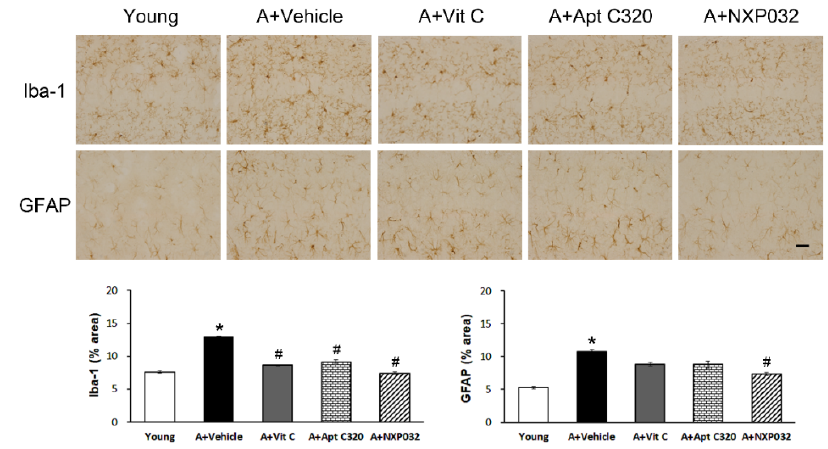
Figure 3. Effect of NXP032 on aging-induced microglial activation in the hippocampus. ( Upper ) Representative photographs of immunostaining of Iba-1 in the hippocampal CA1 region. ( Lower ) Representative photographs of immunostaining of GFAP in the hippocampal CA1 region. The data are presented as the mean ± S.E.M. * p < 0.05, compared to the young group. # p < 0.05, compared to the aging-vehicle group. Scale bar: 50 µm.